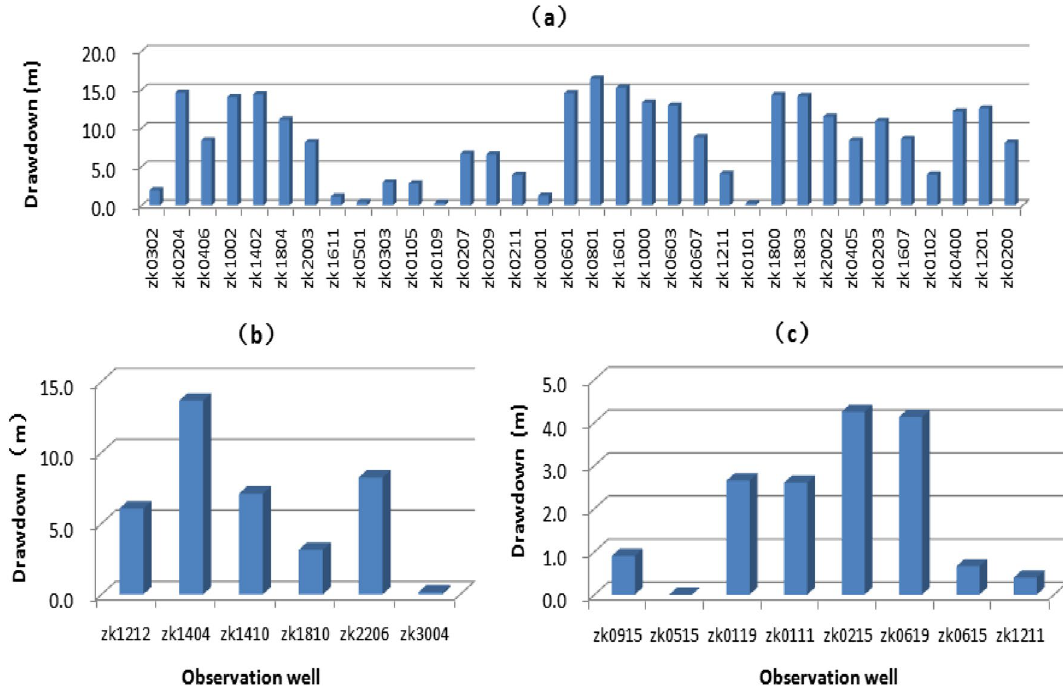
Figure 9. The drawdown of potassium-rich brine deposits in Lop Nor basin. ( a ) The depth of brine drawdown in Luobei depression. ( b ) The depth of brine drawdown in Tenglong mining area, ( c ) The depth of brine drawdown in Xinqing platform. The abscissa is the observation well number.